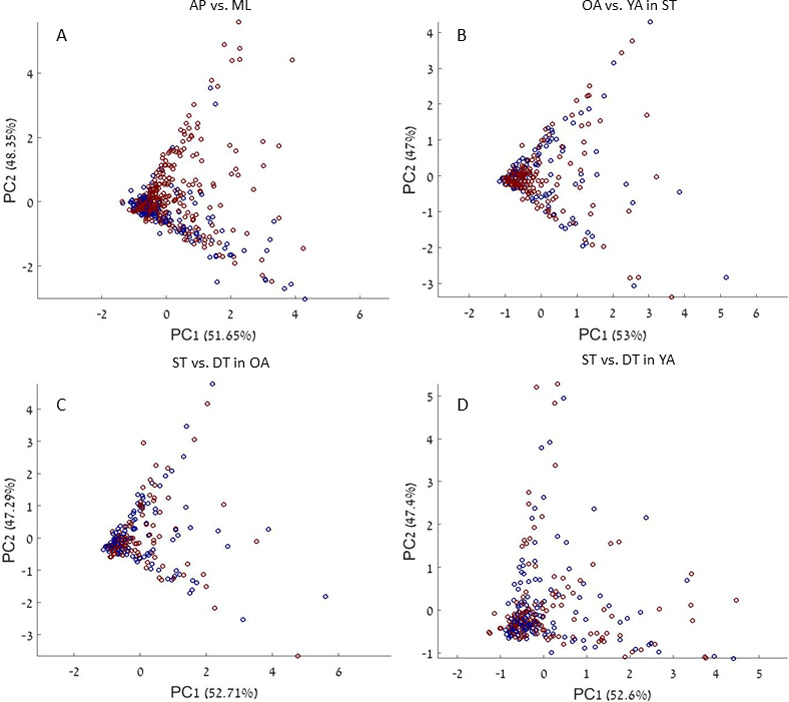
Principal component plots of total recovery time values.Principal component plots of total recovery time values for regaining stable gait parameters (step length and step width) for the following comparisons: (A) perturbation direction–anterior-posterior (blue dots) versus medio-lateral (red dots); (B) group–older adults (blue dots) versus young adults (red dots); (C) cognitive load conditions–single task (blue dots) versus dual task (red dots) among older adults; and (D) cognitive load conditions–single task (blue dots) versus dual task (red dots) among younger adults. PC1 and PC2 are the two components found by the PCA, and the percentages represent the percent of variation explained in the data by each component (see scree plots, S2 Fig, in S1 Appendix).